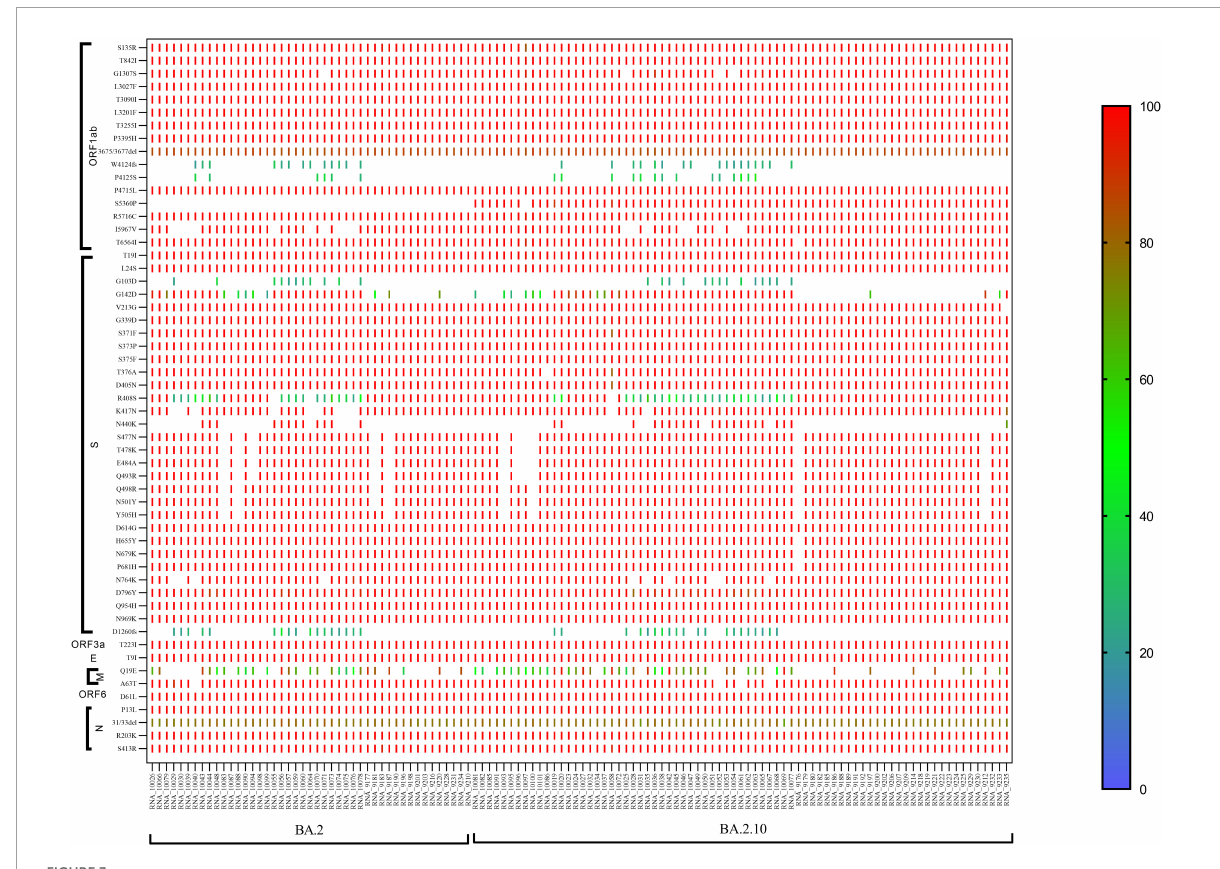
FIGURE3 CLC genomics showing the mutational changes in the sub-lineage BA.2 and BA.2.10 of the Omicron variant. The scale representing the frequency of residue changes from least (Blue) to highest (Red) . S, spike protein; E, envelope protein; M, membrane protein; N, nucleocapsid protein.